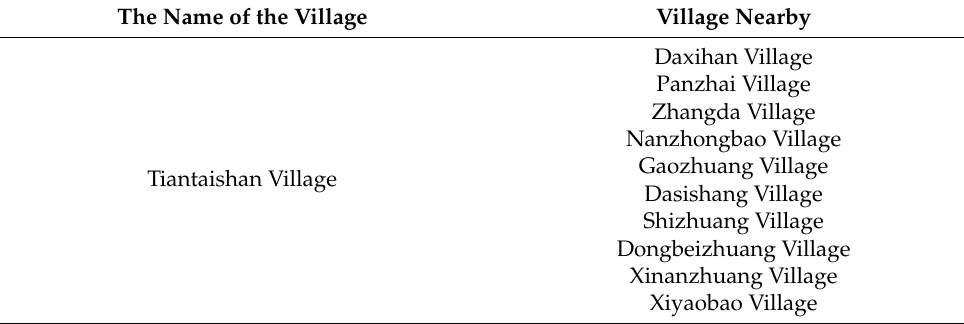
Table 6. Search results (Tiantaishan Village). The Name of the Village